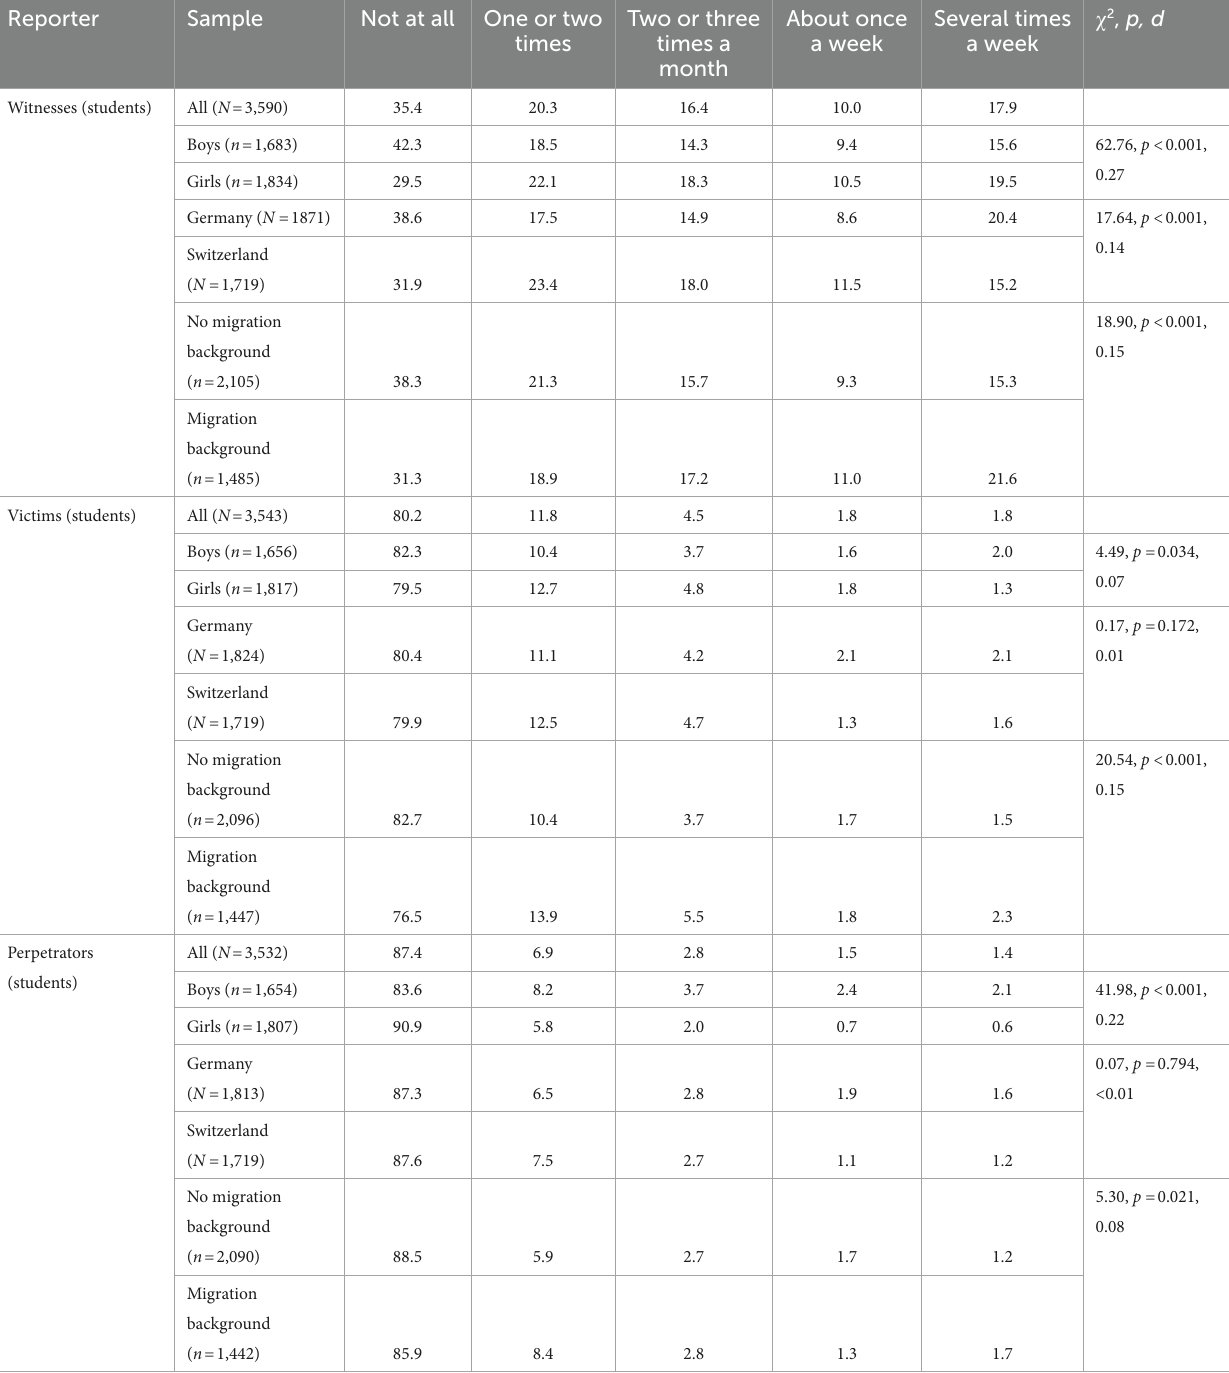
TABLE 2 Frequency of witnessed, experienced and perpetrated online hate speech, by country, gender, and migration status of reporters. Reporter